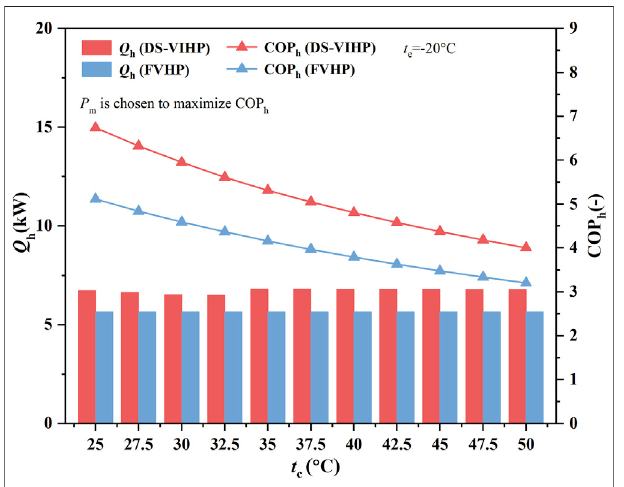
FIGURE 6 | Performance comparison under different condensing temperatures.